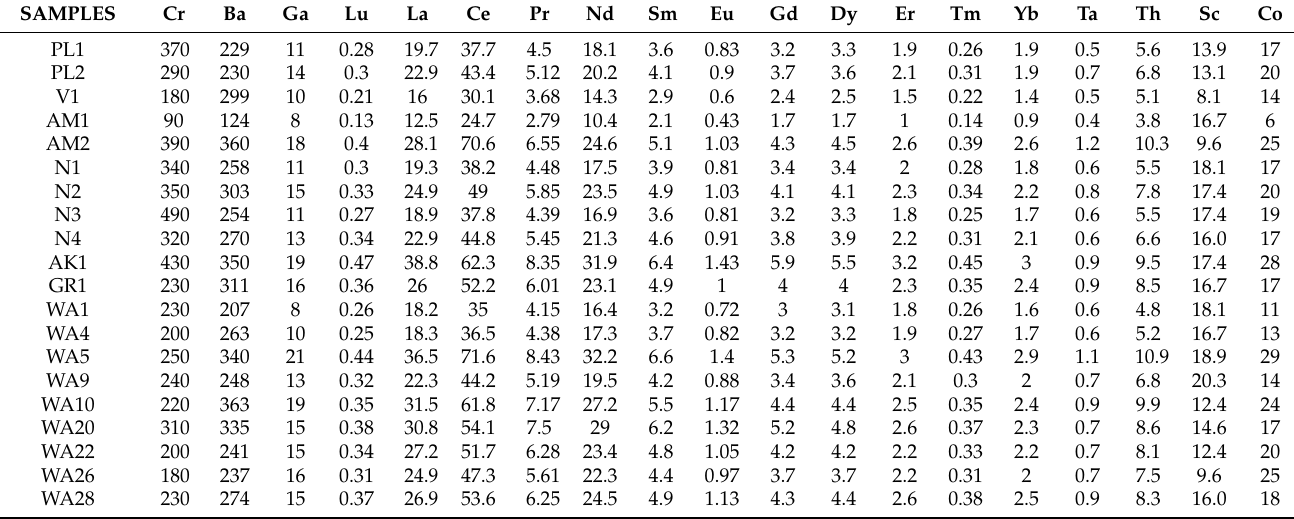
Table A2. Elemental concentrations obtained through inductively coupled plasma mass spectrometry (ICP-MS) for the clay-rich samples.